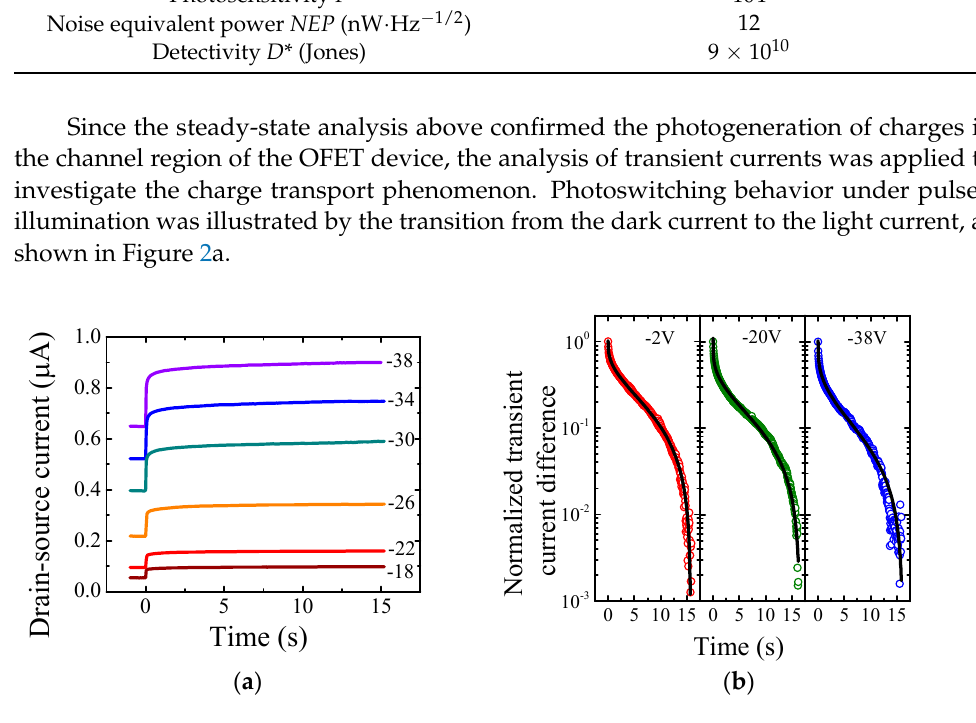
Figure 2. ( a ) The transient drain ‐ source currents in time domain recorded for various gate ‐ source voltages. The time 0 s denotes beginning of the illumination; hence, the current in negative time region represents the dark current. ( b ) The normalized transient current difference in semi ‐ log scale for selected gate ‐ source voltages. Solid lines represent the stretched exponential function fit.